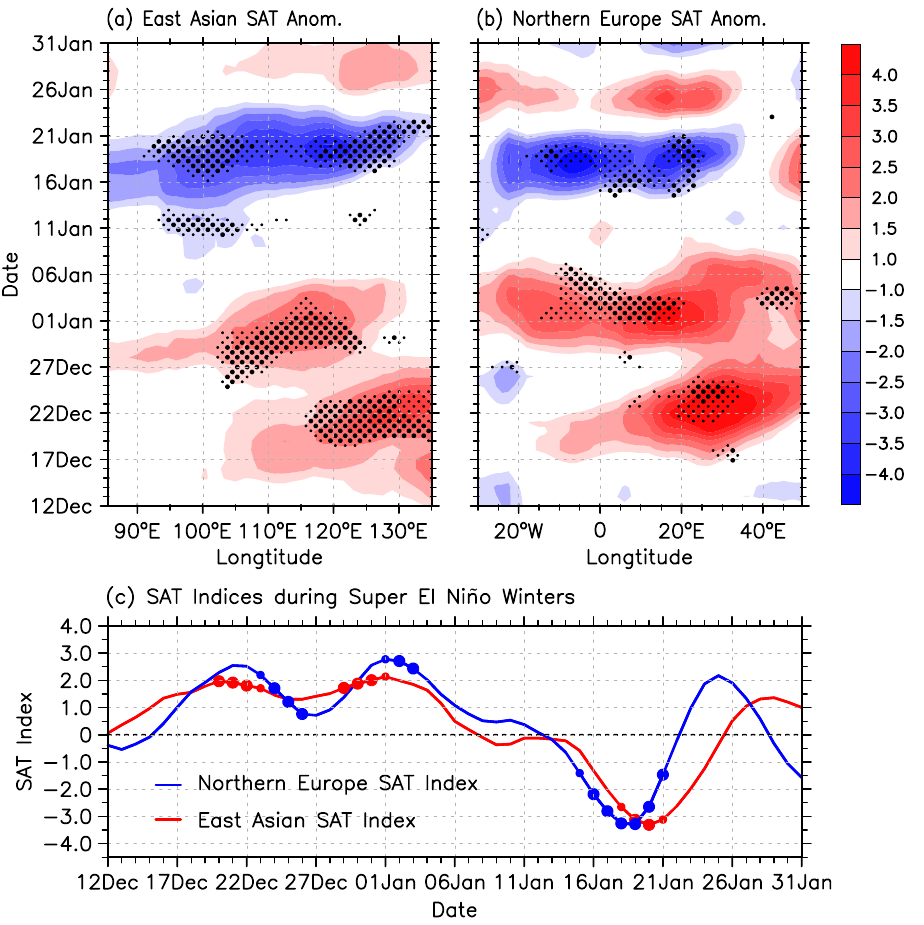
Figure 2. Regional wintertime SAT responses to super El Niño on the sub-seasonal timescale. Composite time- longitude sub-seasonal variation of ( a ) East Asian (25°–55°N average) and ( b ) Northern Europe (60°–80°N average) SAT anomalies (°C) for super El Niño winters (1982/83, 1997/98, and 2015/16). Small and big black dots indicate the anomalies above the 90 and 95% confidence levels, respectively. ( c ) Composite sub-seasonal variability of the East Asian (red line) and Northern Europe (blue line) SAT indices (°C) for super El Niño winters. Small and big dots represent the corresponding SAT anomalies above the 90 and 95% confidence levels, respectively. The figure was generated with the NCAR Command Language (Version 6.3.0) [Software] (2015). Boulder, Colorado: UCAR/NCAR/CISL/TDD.